Question: Is the quantity shown trending increasing or decreasing?
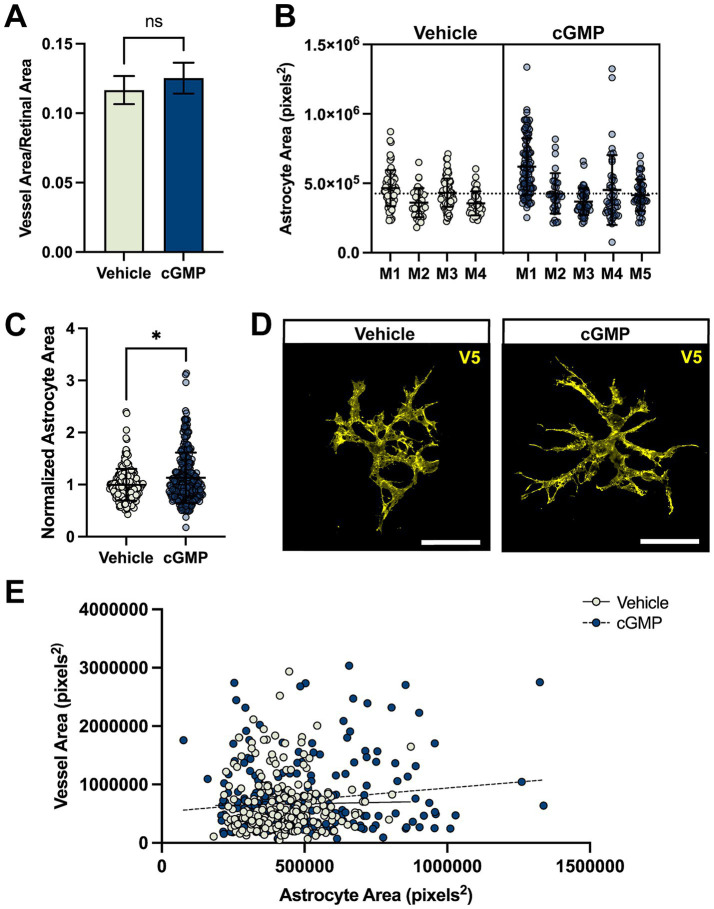
Answer: increasing